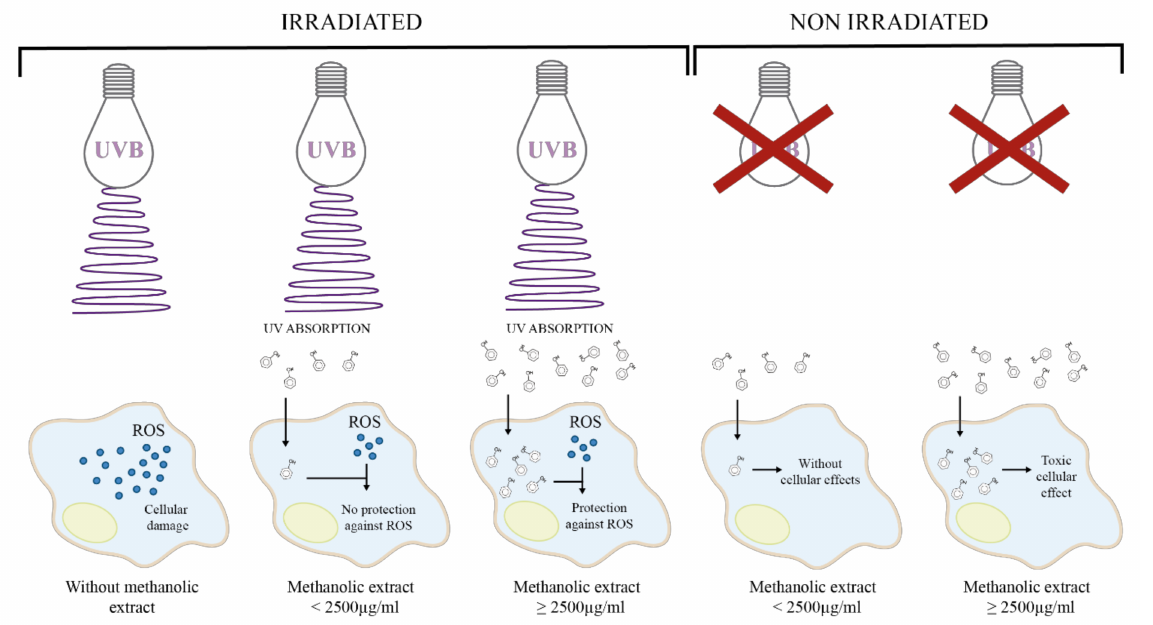
Figure 4. Proposed molecular characteristics of the B. cordata cell culture methanolic extract that underlie its photoprotective activity and cytotoxic effects on 3T3-Swiss albino